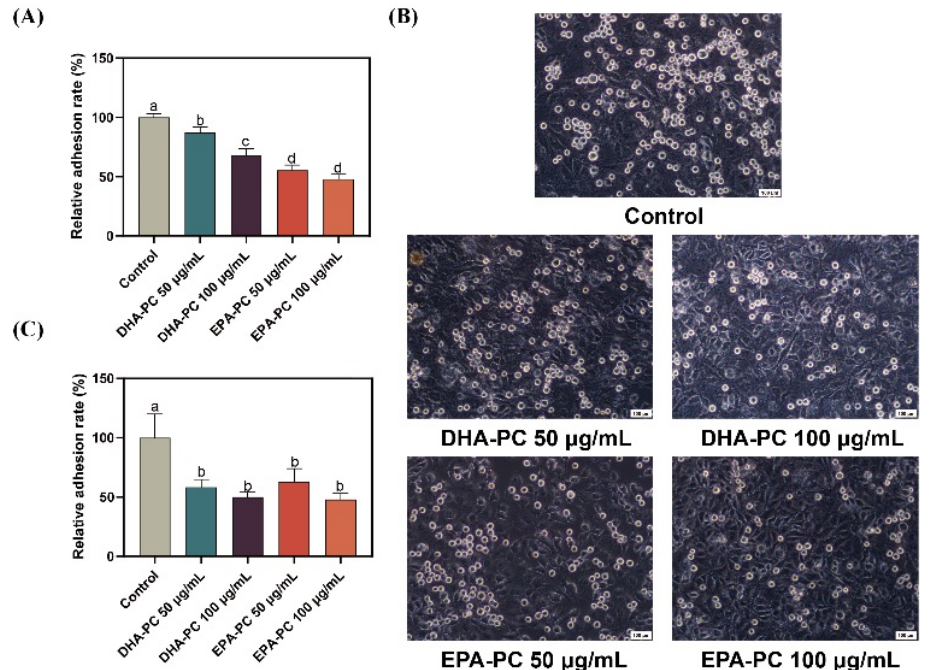
Figure 2. DHA-PC and EPA-PC suppressed the adhesion of 95D cells to ECM and HUVECs. ( A ) Quantification of 95D cells adhered to the Matrigel. ( B ) The representative images of 95D cells adhered to the HUVECs monolayers (Scale bar: 100 µ m). ( C ) Quantification of 95D cells adhered to the HUVECs monolayers. Different letters (a, b, c, and d) indicate remarkable differences at p < 0.05 among all groups determined by ANOVA (Bonferroni’s